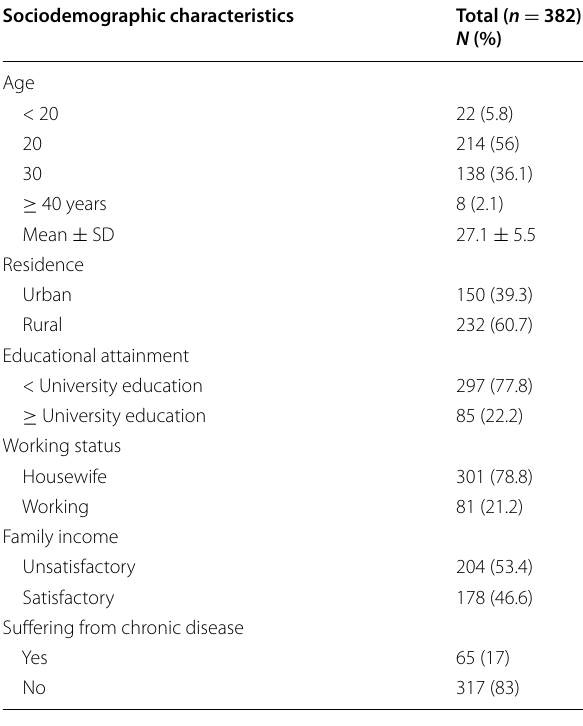
Table 1 Sociodemographic characteristics of the studied pregnant women attending antenatal care (ANC) clinics in Mansoura district, Egypt, 2020 ( n 382) = Sociodemographic characteristics